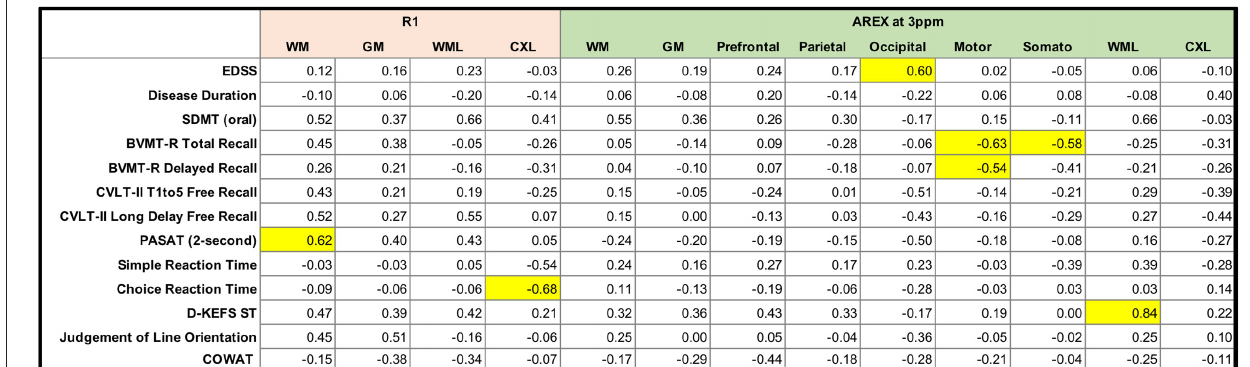
Frontiers in Neurology |